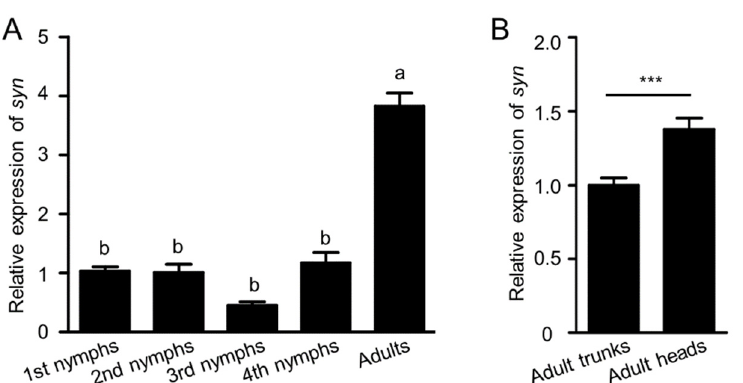
Figure 2. Assessment of the relative gene expression of synapsin in various development stages of the melon aphid. ( A ) Expression profiles of synapsin at different stages. The relative expression of synapsin in the first instar nymph was normalized to 1. The letters above each column indicate significant differences (Tukey’s multiple comparison test, p < 0.05). ( B ) The expression profile of synapsin in different tissues. *** indicates the significance by pairwise comparison (Student’s t -test, *** p < 0.001).